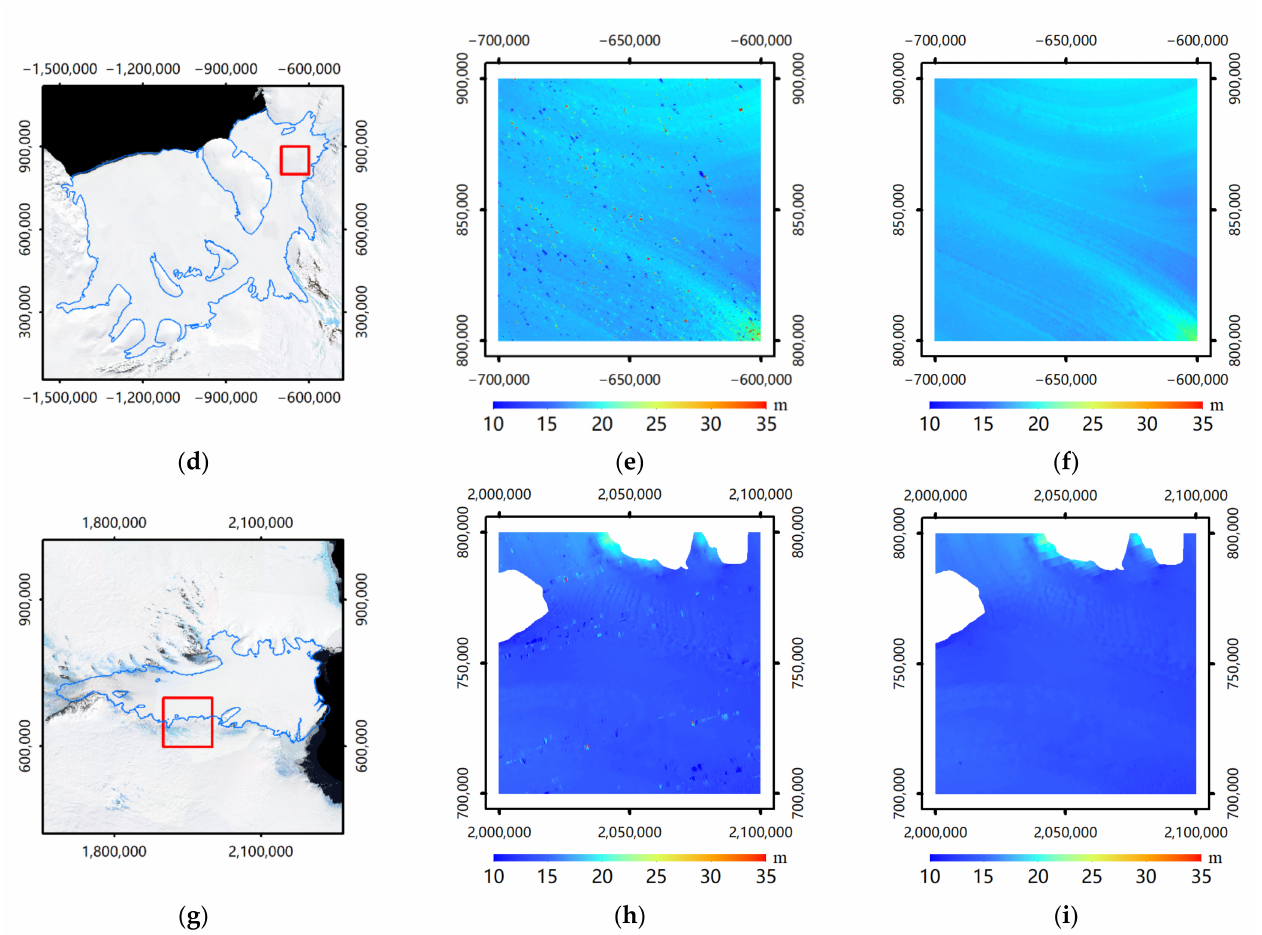
Figure 2. Digital elevation models (DEMs) of experimental areas in the RIS, the FRIS, and the AIS derived from Ice, Cloud, and Land Elevation Satellite-2 (ICESat-2) data by kriging with linear variogram model and spherical variogram model. ( a ) experimental areas in the RIS; ( b ) RIS DEM based on linear variogram model; ( c ) RIS DEM based on spherical variogram model; ( d ) experimental areas in the FRIS; ( e ) FRIS DEM based on linear variogram model; ( f ) FRIS DEM based on spherical variogram model; ( g ) experimental areas in the AIS; ( h ) AIS DEM based on linear variogram model; ( i ) AIS DEM based on spherical variogram model. The areas in the red box are the experimental areas and the blue line is the coastline. Maps are in the polar stereographic projection in meters.